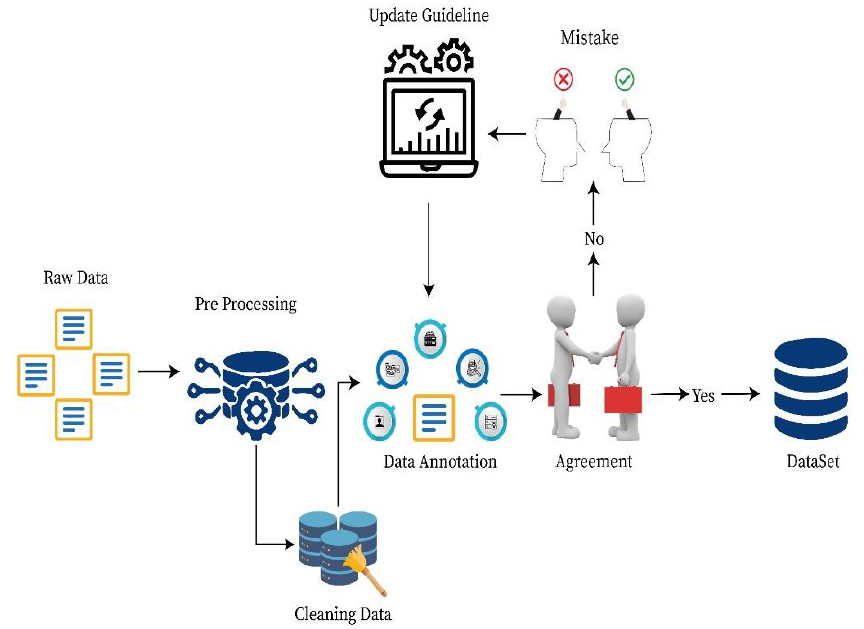
Figure 2. Explain Data Annotation Technique.